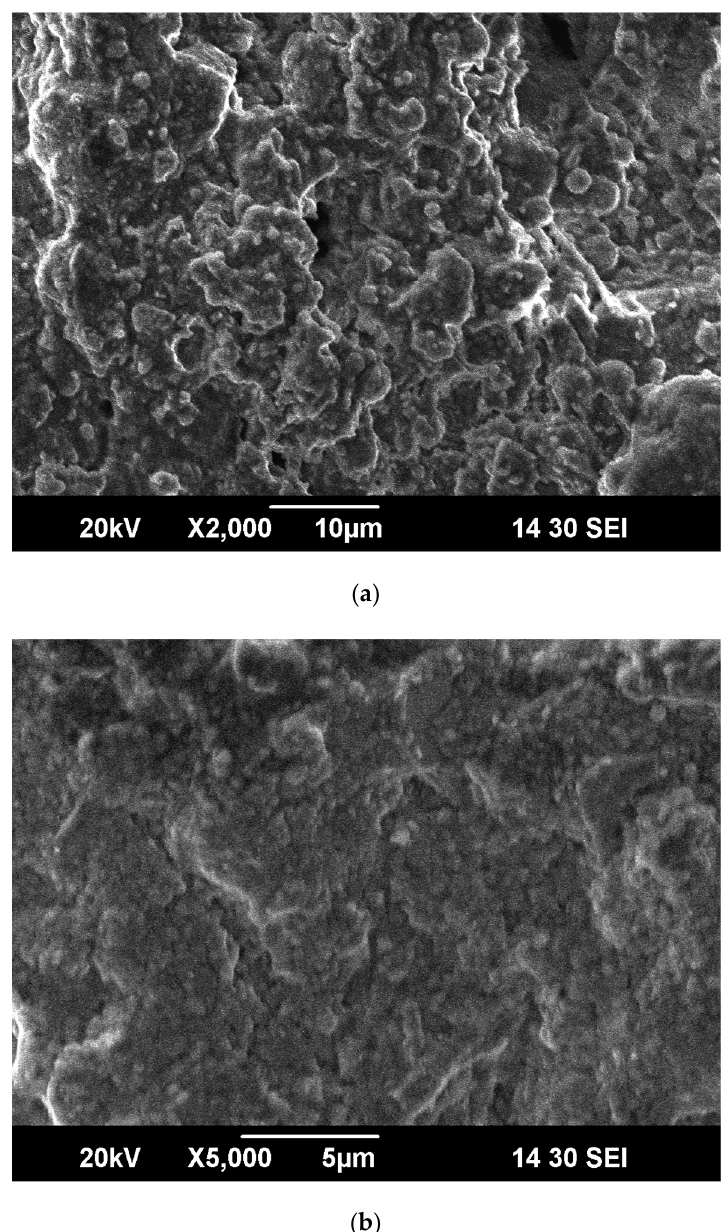
Figure 7. SEM image of support surface magnified 2000 and 5000 times. ( a ) 2000 times. ( b ) 5000 times.